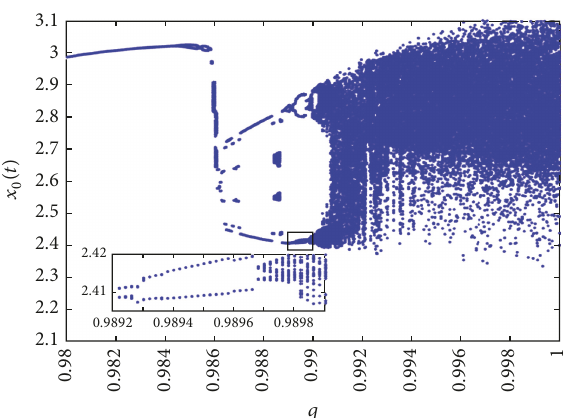
Figure 2: Bifurcation diagram of the fractional-order 𝑞 with 𝛼 = 0.5, 𝑓 = 8.3, 𝑤 = 1.0, 𝜎 = 0.001